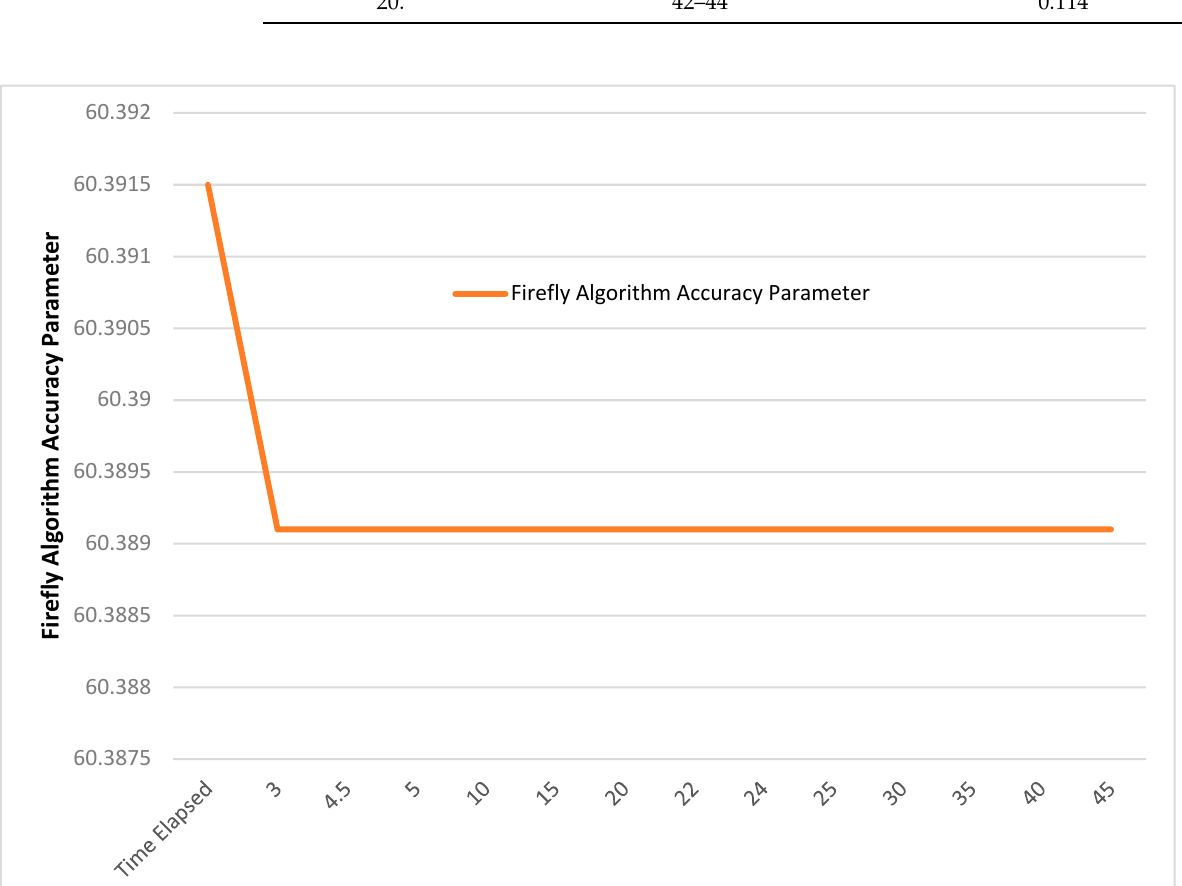
Line No. Figure 7. Voltage Deviation of Indian 62 Bus system for various contingencies. HS = Healthy System. The solar integrated system is then analyzed for contingency conditions with and without IPFC. The tuning of IPFC has been performed using the Firefly algorithm [18]. The time elapsed for the tuning is 232.59 s. The improvement in the accuracy in result by Firefly Algorithm is shown in Figure 8. The figure shows that the accuracy level has been achieved in less than 5 s.